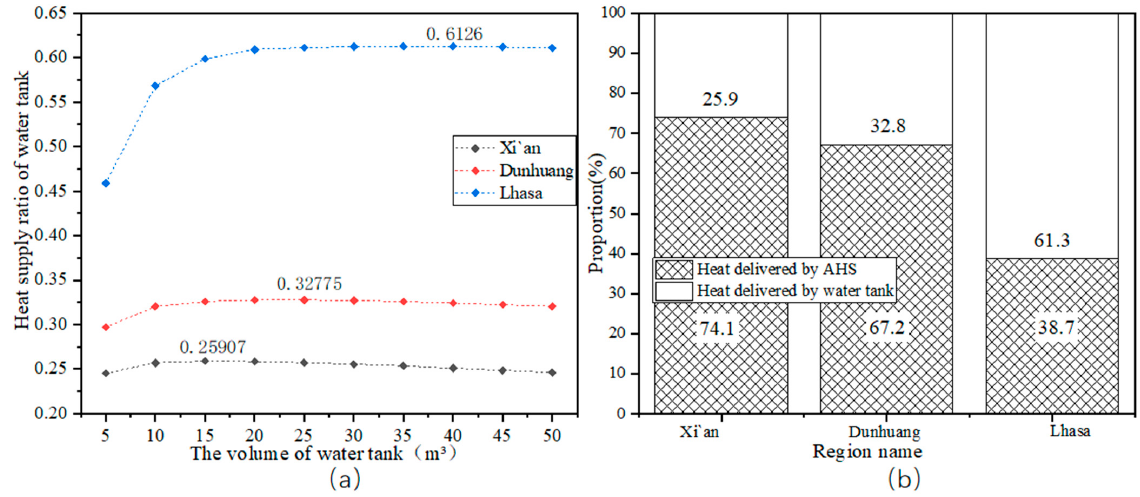
Figure 8. ( a ) Optimization analysis of HSWTs in different regions; ( b ) comparison of final optimization results.